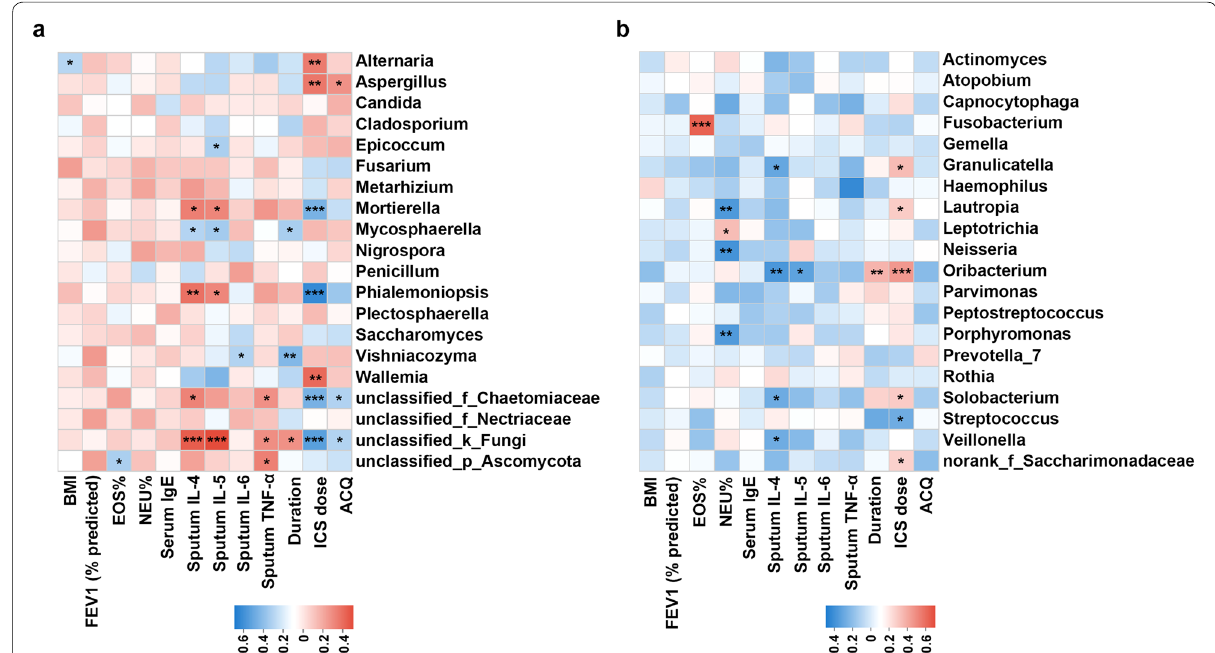
Fig. 5 Correlation between airway mycobiome ( a ), bacteriome ( b ) and clinical indices of asthma. Correlations were performed based on Spearman correlation. Red indicates positive correlation; blue indicates negative correlation. ***p